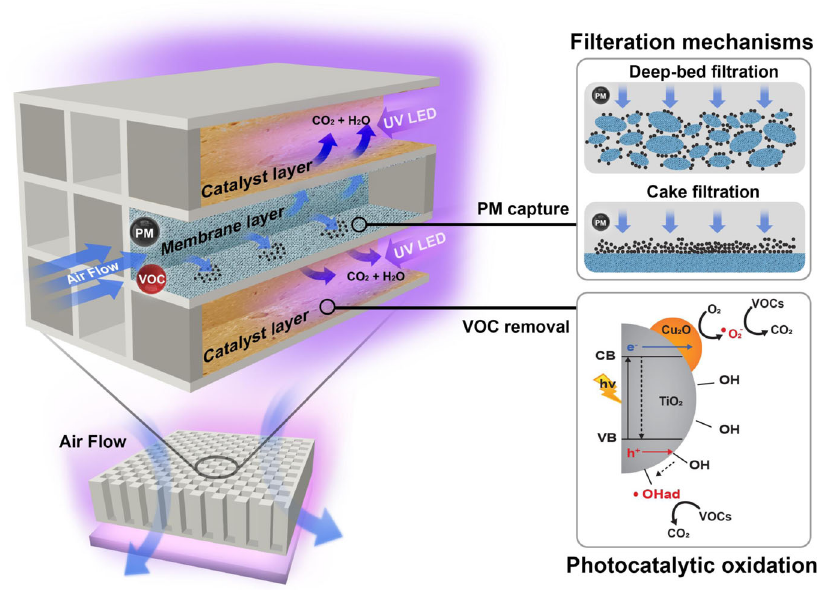
Fig. 1 | Design concept of Ceramic Catalyst Filter (CCF) system. The illustration shows a rational design concept for CCF preparation. Two main mechanisms, namelywall- fl ow fi ltrationofPMbyporousceramic fi lterwithtwotypesof fi